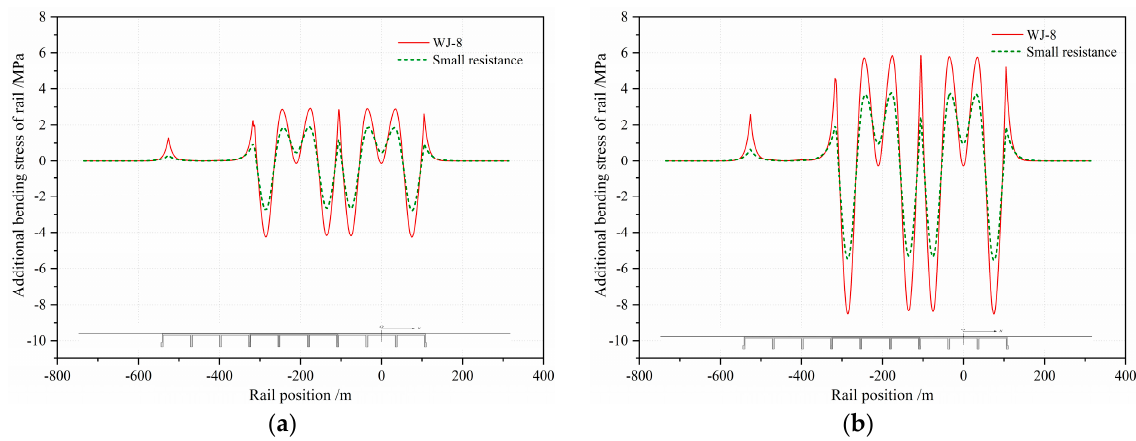
Figure 11. Additional bending force of rails: ( a ) under a single-line train; ( b ) under double-line trains.